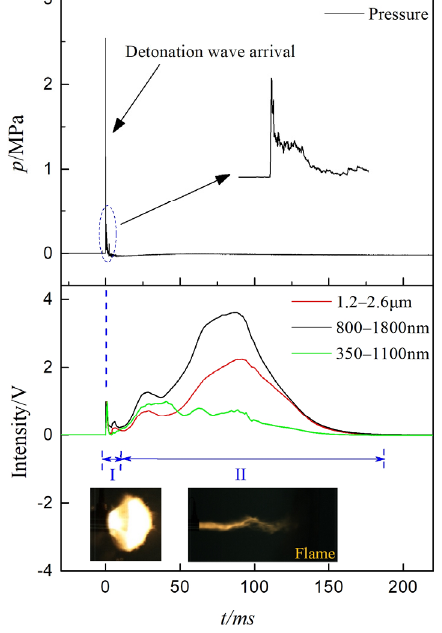
Figure 4. Curves of detonation pressure and radiation signal at different processes. (I: detonation wave exits from the tube; II: detonation products exhaust from tube).